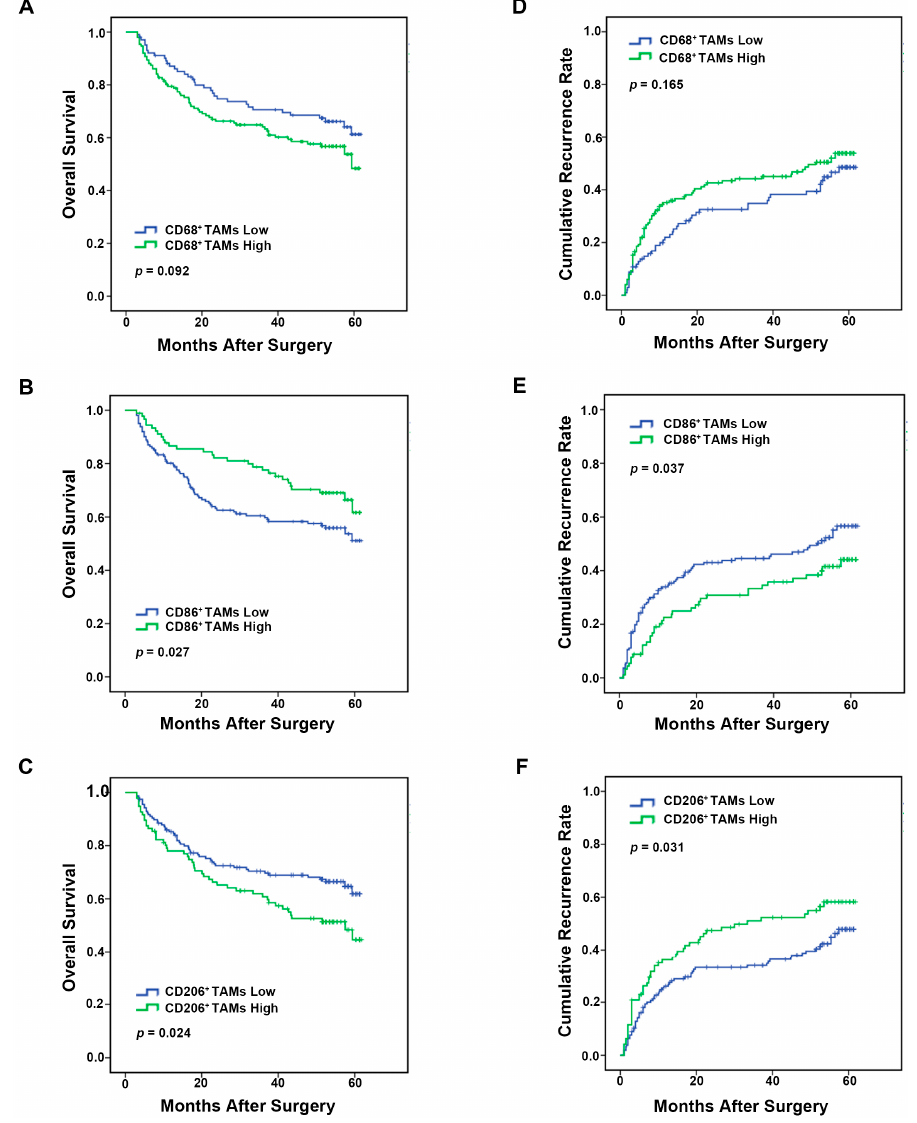
Figure 3. Kaplan–Meier curves for overall survival ( A – C ) and time to recurrence ( D – F ) of hepatocellular carcinoma (HCC) patients according to the staining presence of CD68 + , CD86 + and CD206 + macrophages in the cohort ( n = 253).